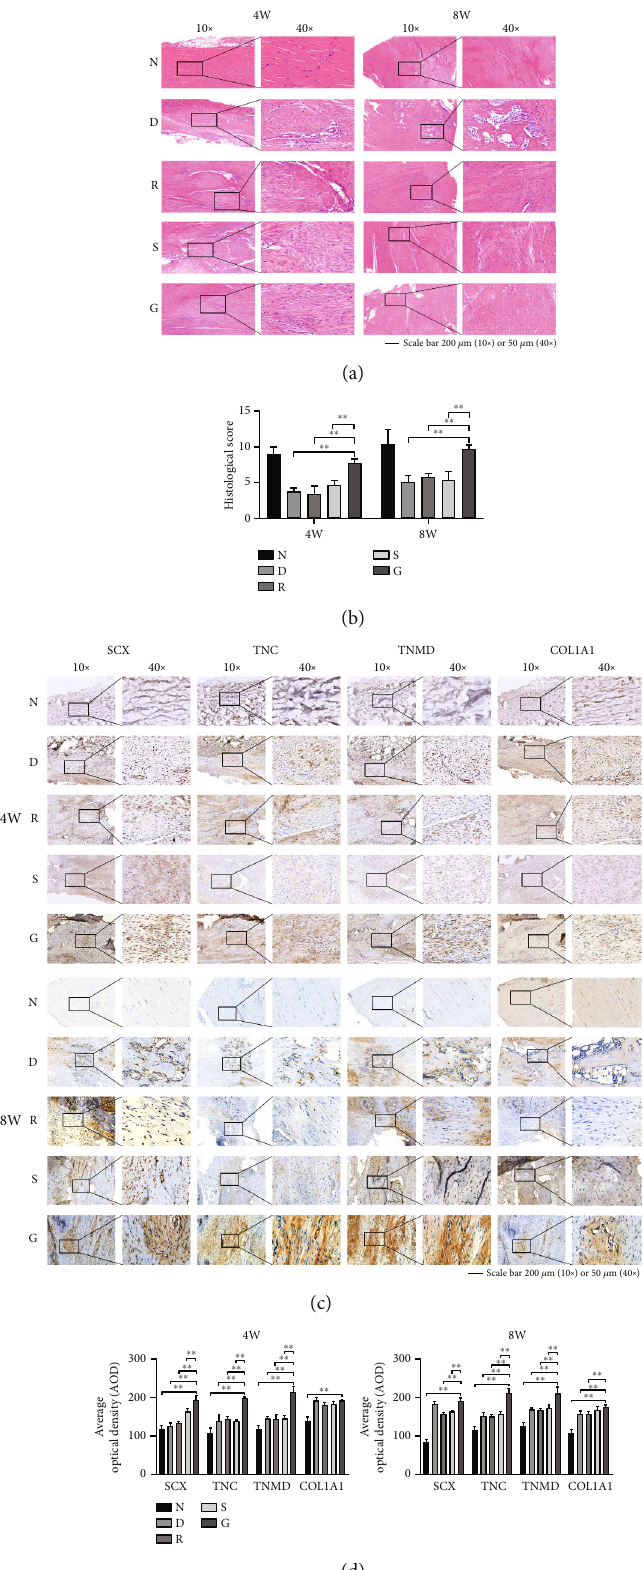
Figure 3: Comparison of histological evaluation of di ff erent repair groups. (a) H&E staining. (b) Histological score. The repair score of Group G was higher than that in the other repair groups. (c) Results of IHC. (d) Statistics of IHC results. The tenogenic markers in Group G were signi fi cantly higher than those in the other repair